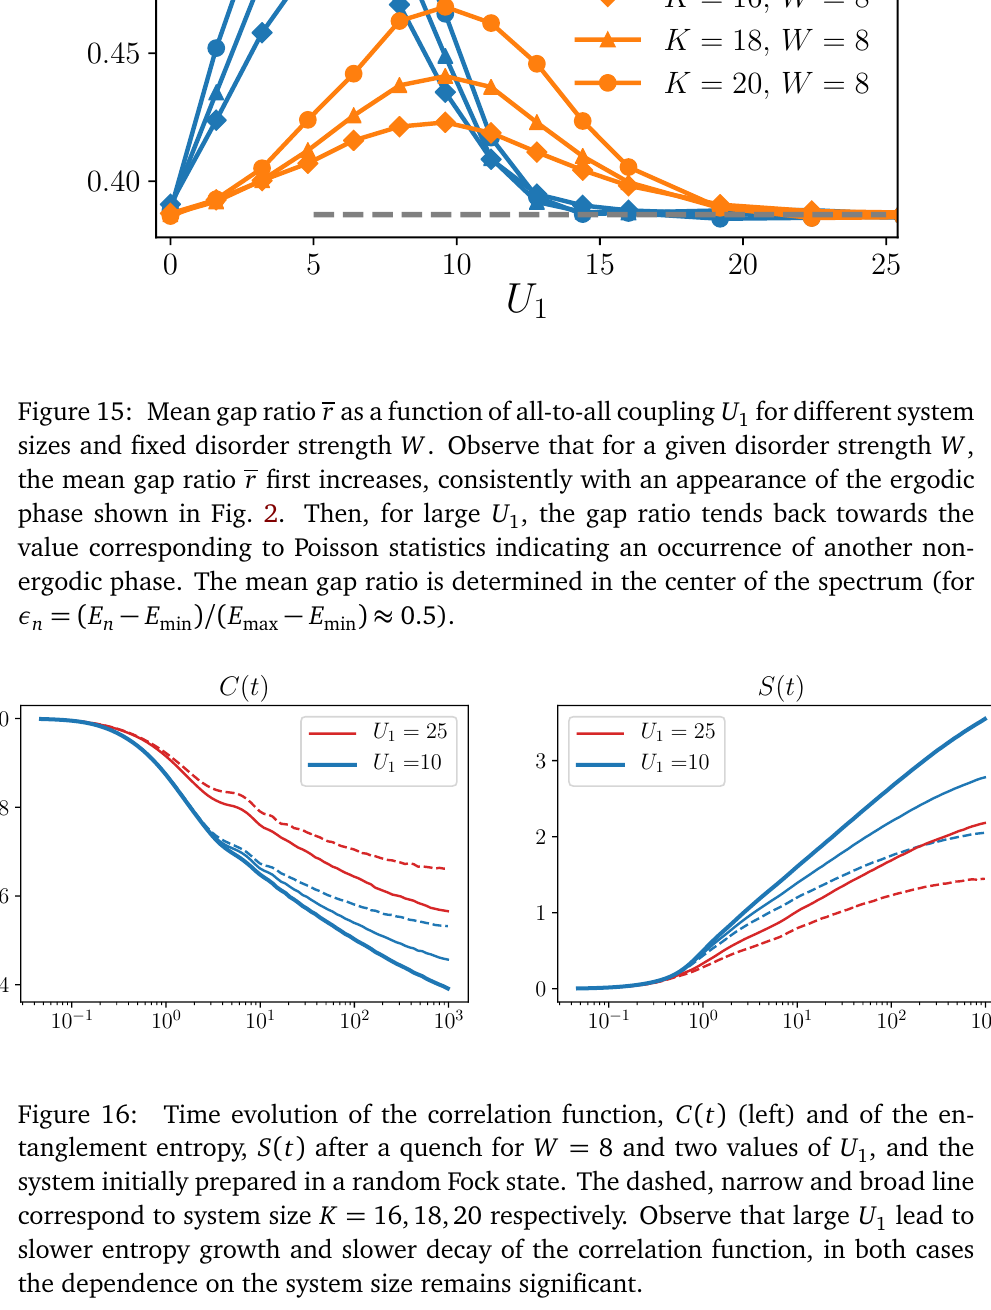
, and the 1 lead to 1